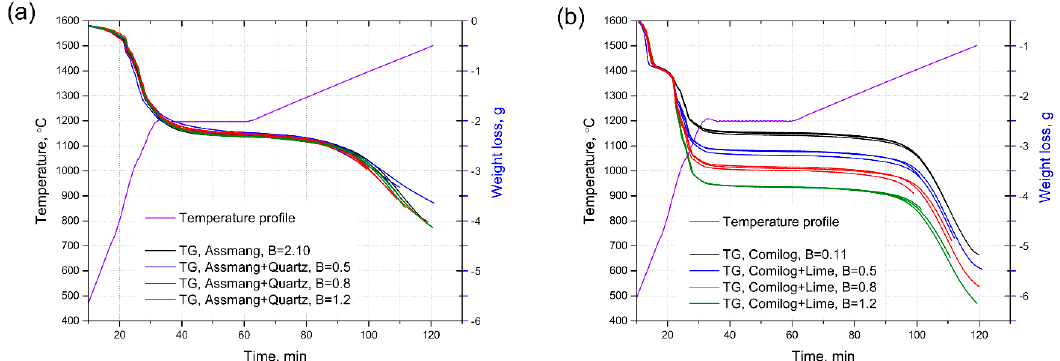
Figure 1. Reduction curves of all charges. ( a ) Assmang series; ( b ) Comilog series. Temperature profile is shown.